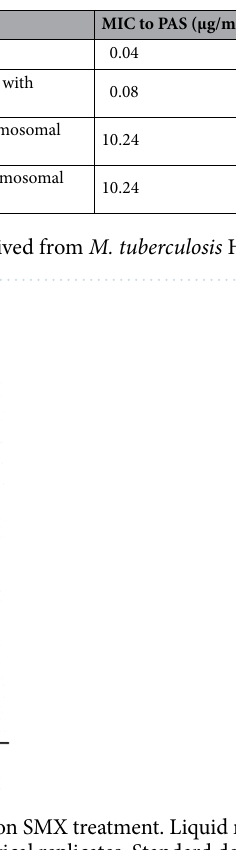
Figure 1. Killing curves of different M. tuberculosis strains upon SMX treatment. Liquid medium (7H9 + 10% OADC) was used. Experiments were performed in three biological replicates. Standard deviations are indicated by error